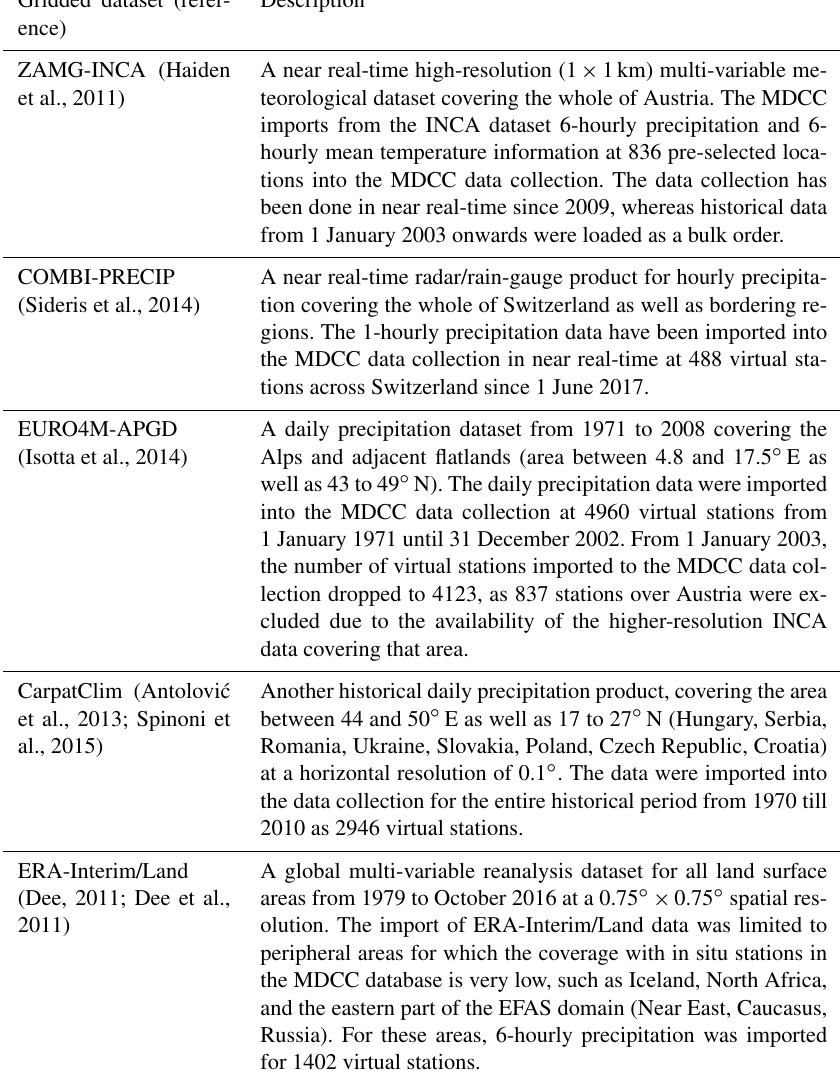
Table 2. Overview of the five gridded meteorological datasets that form the input for EMO-5. Gridded dataset